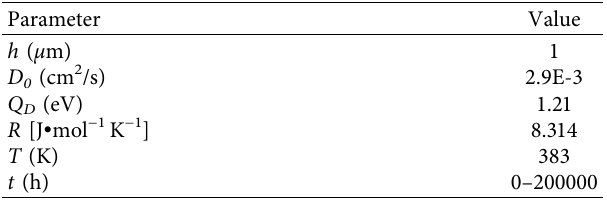
Table 4: Theparametersfor calculatingtherelationship between C and t